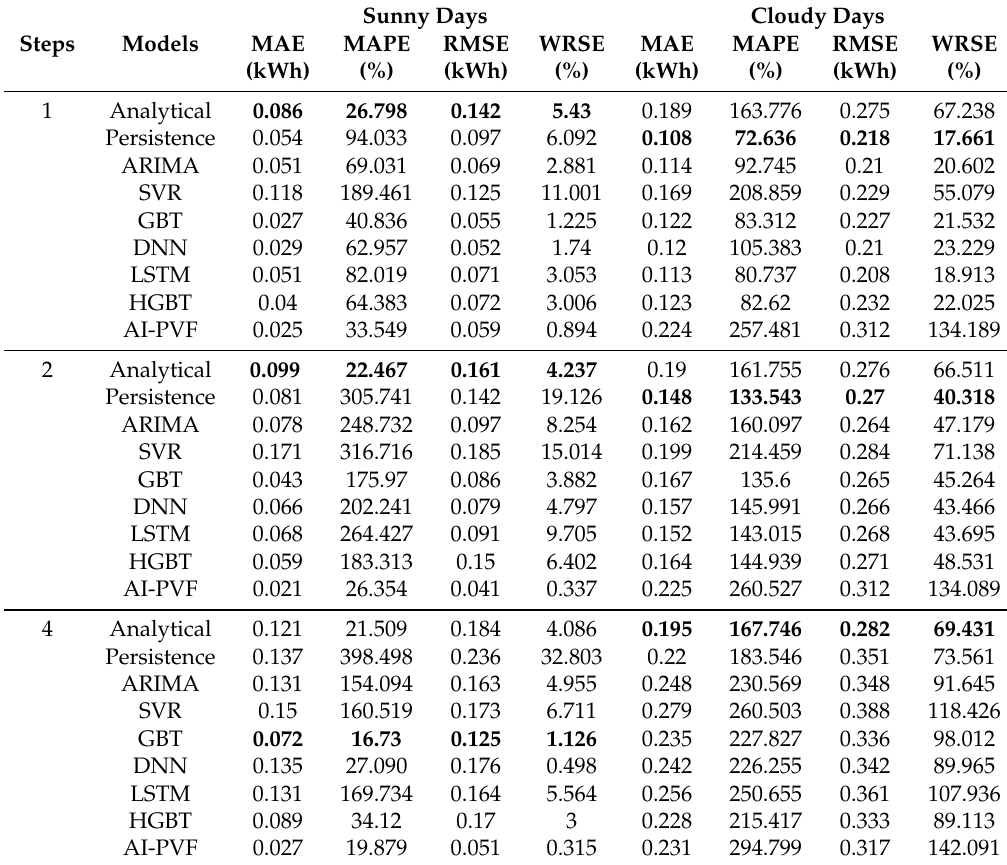
Table 5. Forecasting accuracy results for the autumn